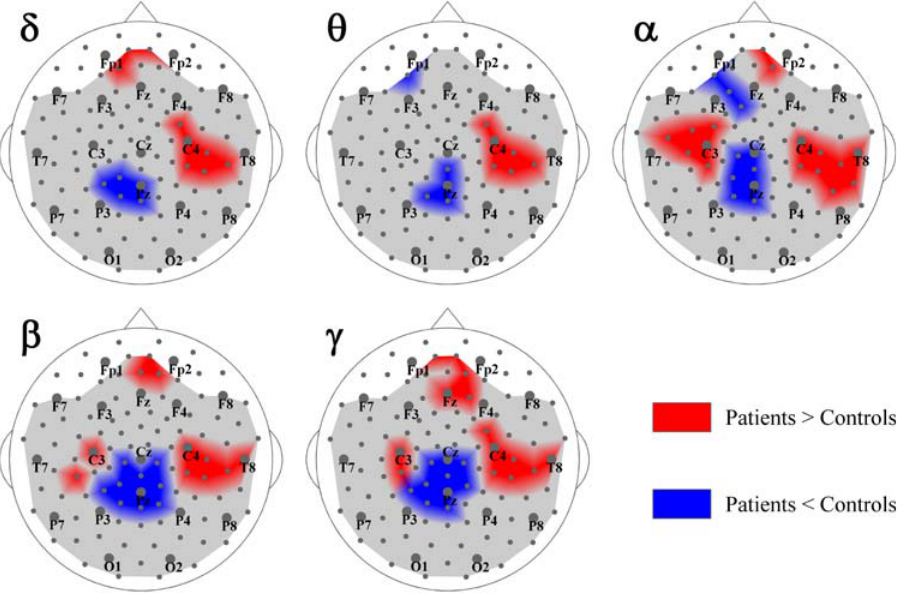
Figure 3. Spectral breakdown of the S-estimator data into conventional EEG bands. Group-averaged difference S-maps (Patients vs. Controls) are given for the following EEG bands: d : 1–3 Hz; h : 3–7 Hz; a : 7–13 Hz; b : 13–30 Hz; and c : 30–70 Hz.